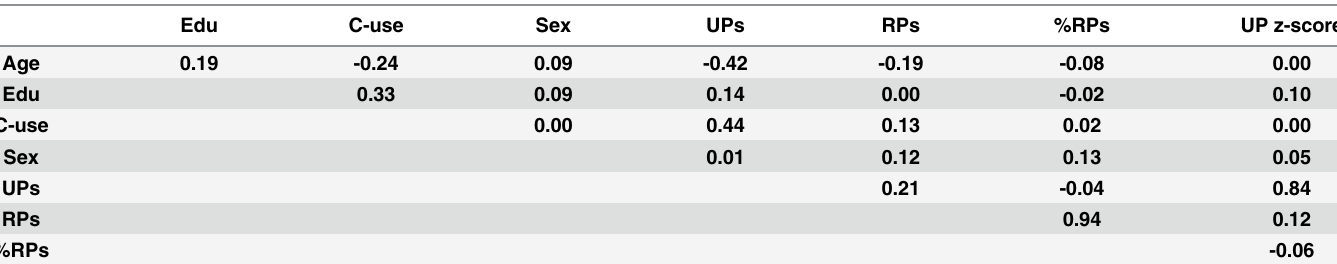
Table 4. Demographic factors influencing